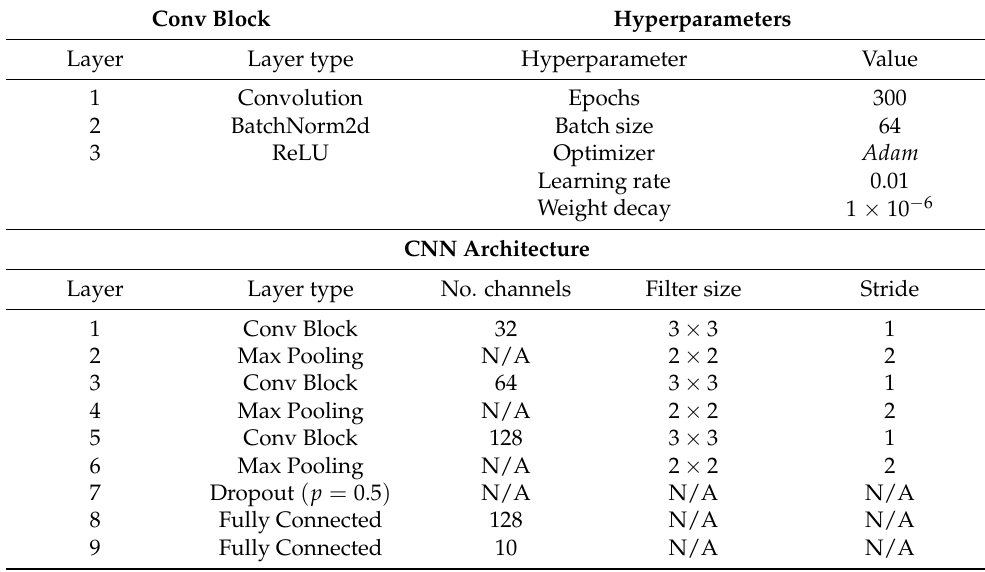
Table 2. CNN used for